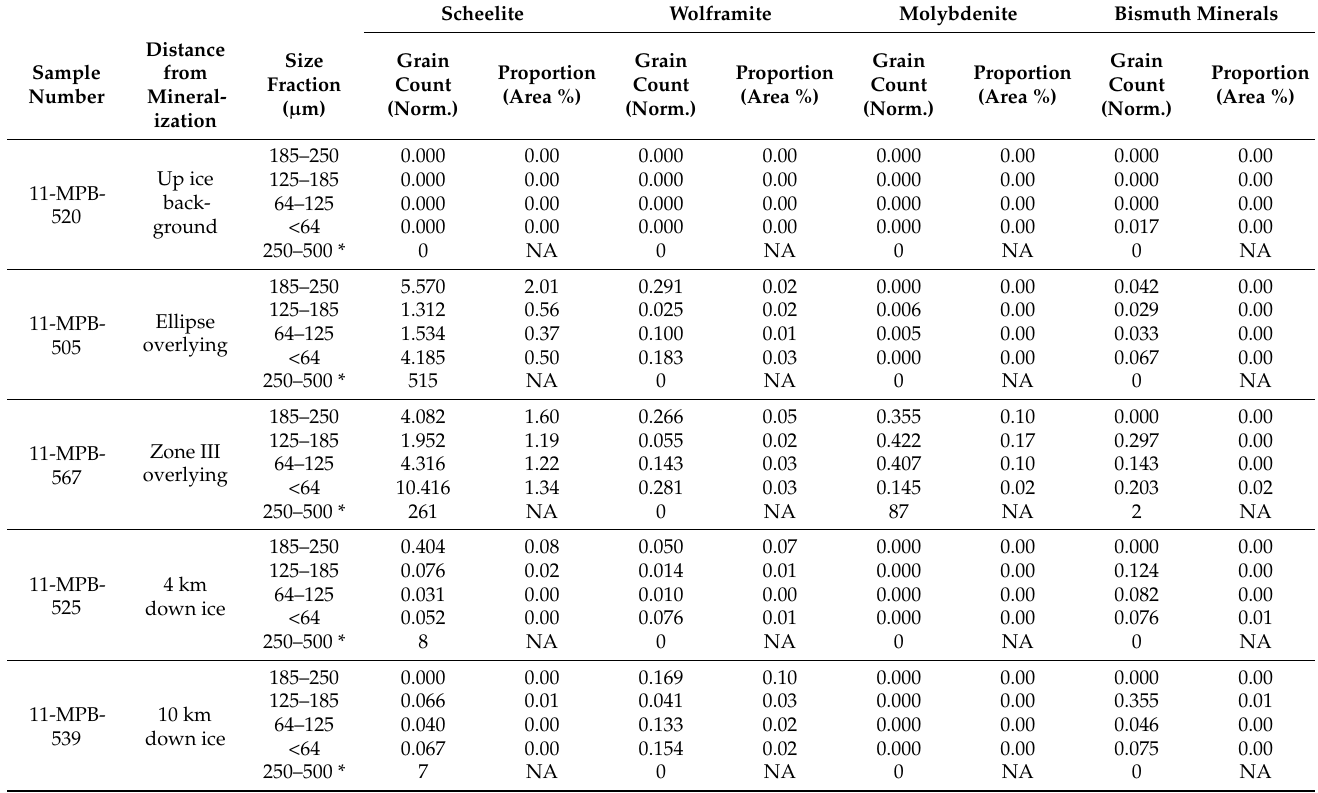
Table 4. Abundance of alteration- and ore-related indicator minerals in five till sample up- and down ice of the Sisson W-Mo deposit. Mineral abundance data are reported in two ways: (1) number of indicator mineral grains per total grains, normalized to 1000 grains; (2) minerals by 2-dimensional percentage area they take up on the polished mount surface. Also included are grain counts from the coarse (250 to 500 µ m) heavy mineral fraction of the same sample obtained by visual grain picking that have been normalized to a 10 kg of sample mass (data from McClenaghan et al.